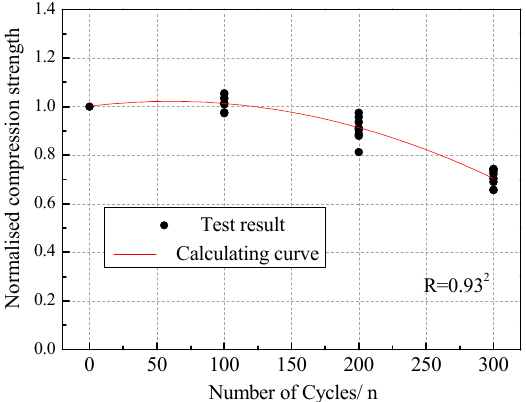
Figure 18. Compressive strength attenuation model.